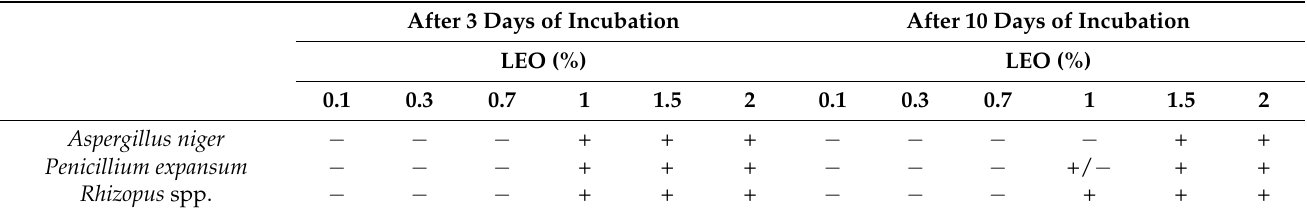
Table 2. Inhibition of mold growth after 3 days and 10 days of